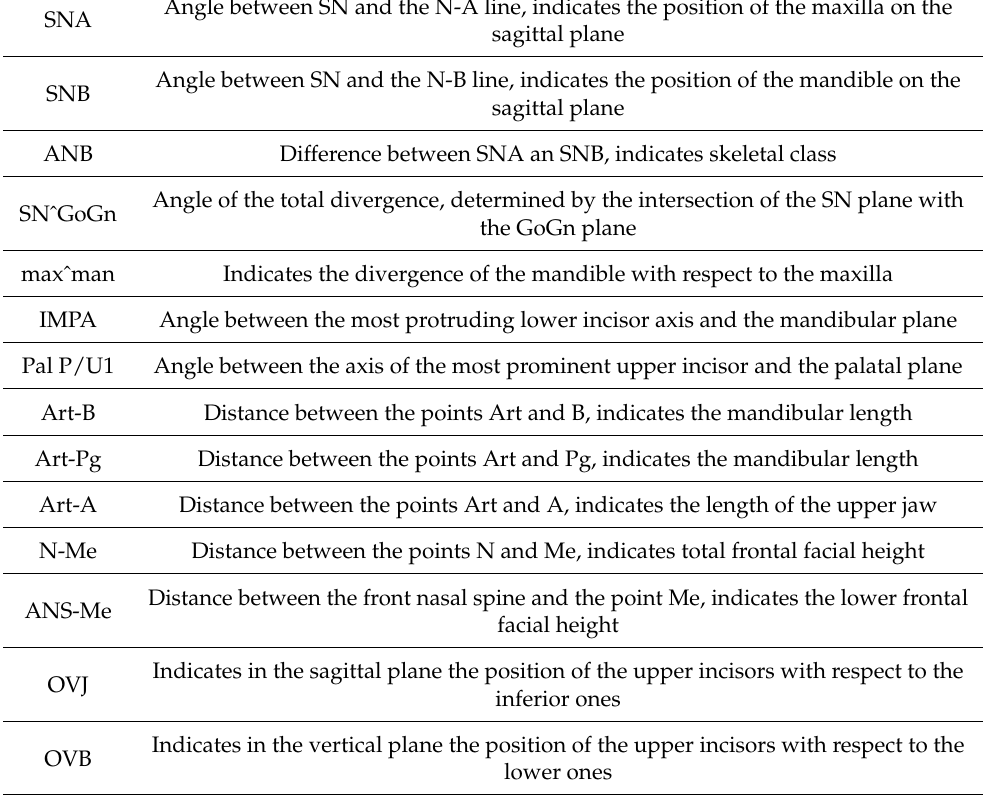
Table 1. Structural cephalometric